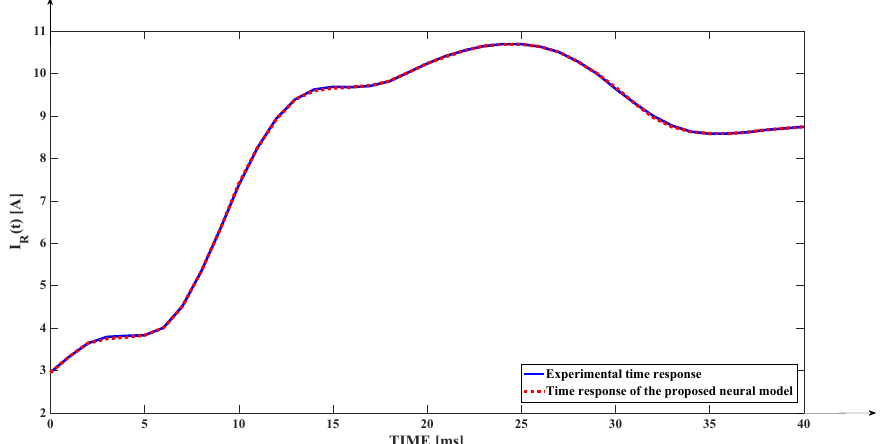
Figure 26. The comparative graph between the I R (t) experimental time response and the response generated by the proposed neural model .